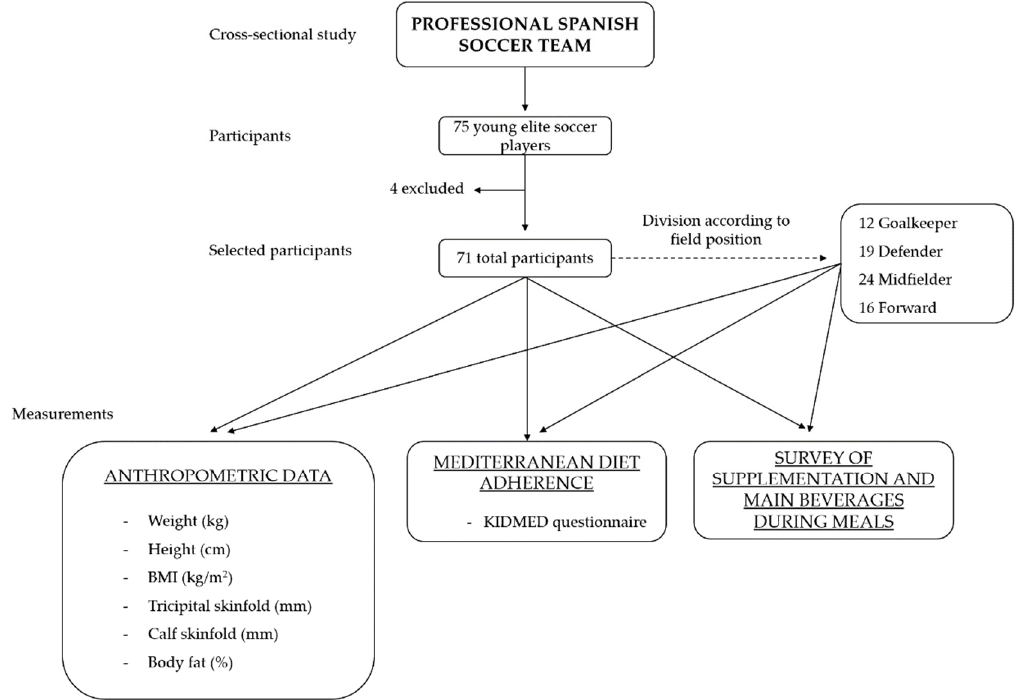
Figure 1. Schematic representation of the study. Seventy-five young male soccer players of the professional Spanish soccer team were recruited. Finally, 4 players were excluded for not having a fixed position on the field. Of the remainder, 12 were goalkeepers, 19 defenders, 24 midfielders, and 16 forwards. Body composition, adherence to the Mediterranean diet, main drinks, and supplements were collected. The analysis was carried out in the global team and by field position.